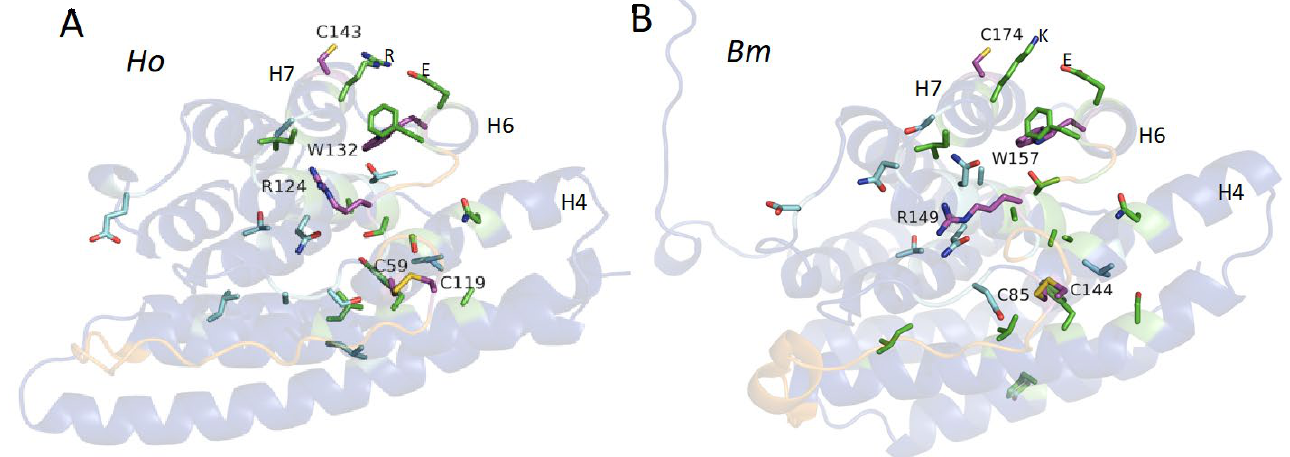
Figure 3. Locations of conserved amino acid sidechains. Both structures are oriented to look through H6. ( A ) H . occidentalis ( Ho ) ( B ) B. mori ( Bm ). Identical amino acids (magenta) are labelled with amino acid number. Strongly conserved amino acids (green) and conserved amino acids (cyan). The H5 → H6 loop is orange. The numbers exclude the SP. H4, H6, and H7 are labelled.